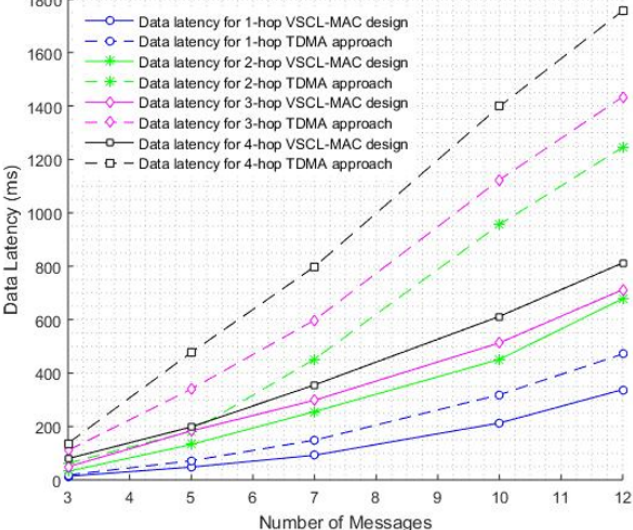
Figure 23. Data latency comparison between proposed design and conventional